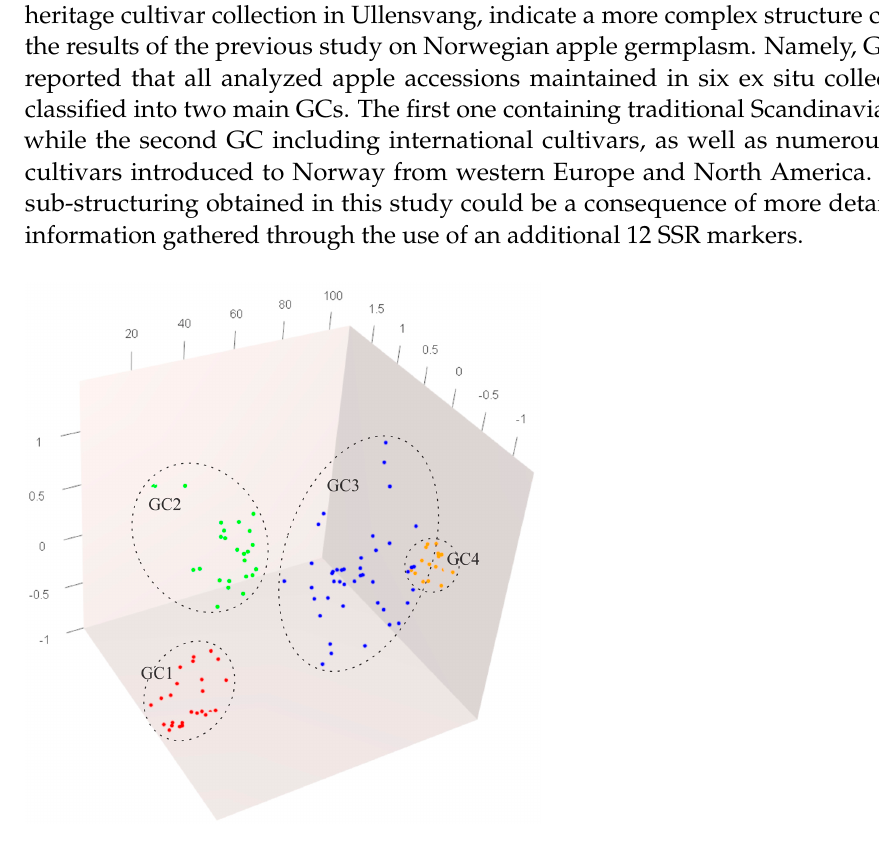
Figure 3. Factorial Correspondence Analysis (FCA) of SSR data for four defined genetic clusters calculated using Structure [32] (only genotypes with the likelihood of membership to individual GC above 80% are included in the analyses).